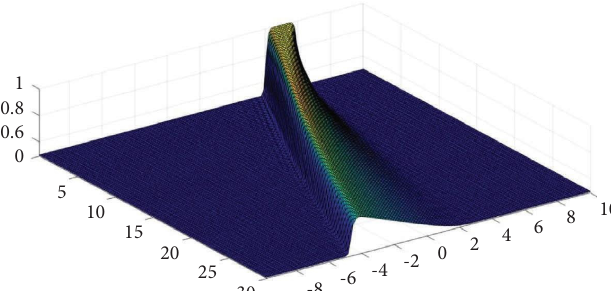
Figure 6: Example 2: for N � 120 and t �